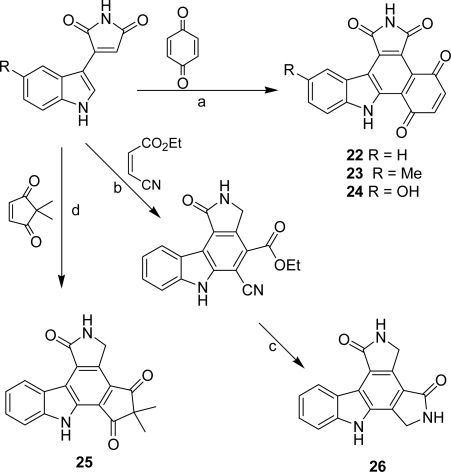
(a) toluene, sealed tube, 140 °C, 12 h. (b) (1) toluene, reflux 5 days, (2) DDQ, dioxane, reflux, 20 h. (c) (1) NaH, THF TBDMSCl, (2) H2, DMF, Raney nickel, 7 days. (d) toluene, 140 °C, sealed tube, 7 days.